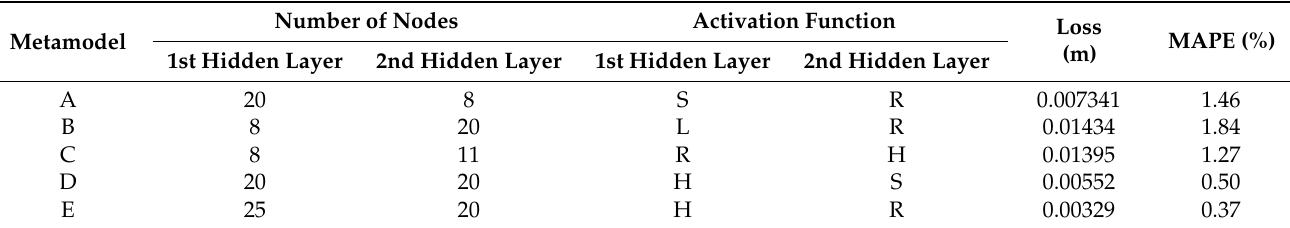
Table 4. Structures of the metamodels and test